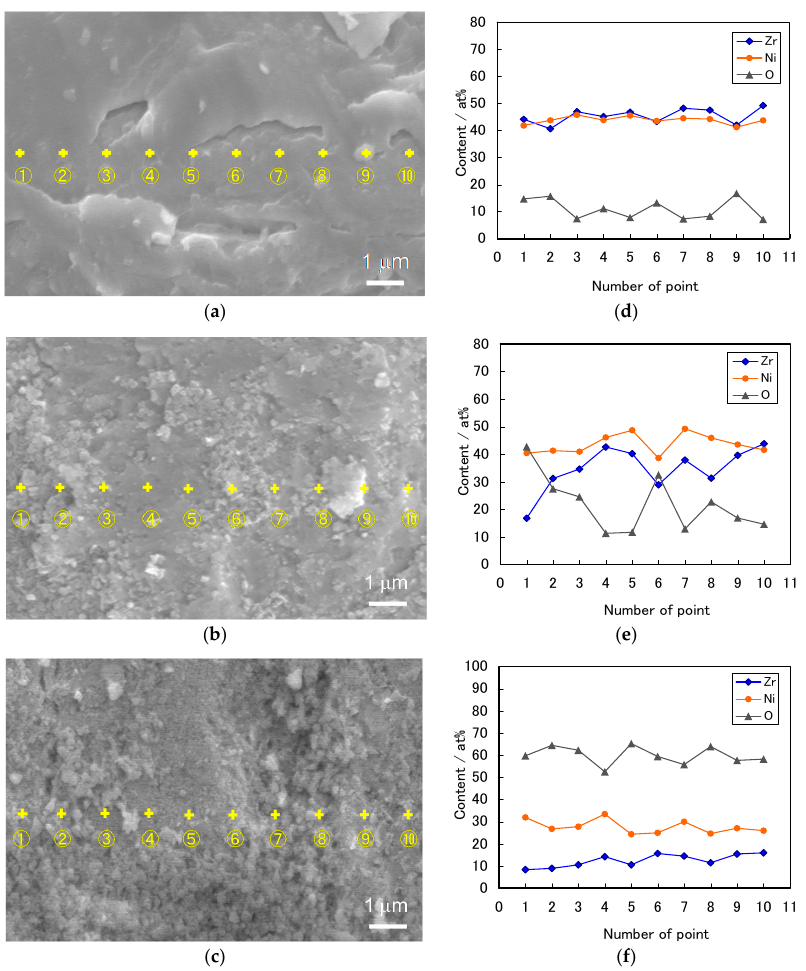
Figure 6. The scanning electron microscopy (SEM) images and Zr, Ni, and O contents at 10 spots analyzed by energy dispersive X-ray (EDX) for the ZrNi alloy powders with and without the boiling alkaline treatments for 2 h and 4 h: ( a,d ) untreated; ( b,e ) 2 h; and ( c,f ) 4 h.